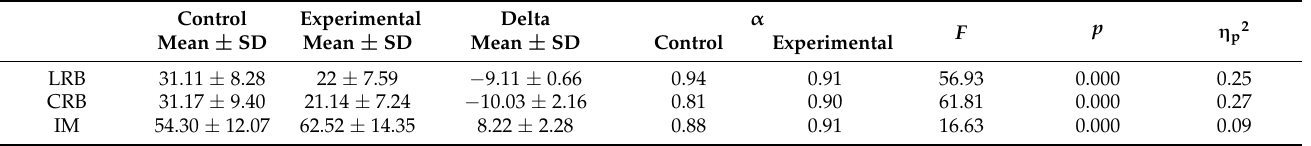
Table 4. Mean and Standard Deviation (Mean ± SD) and summary of the analysis.